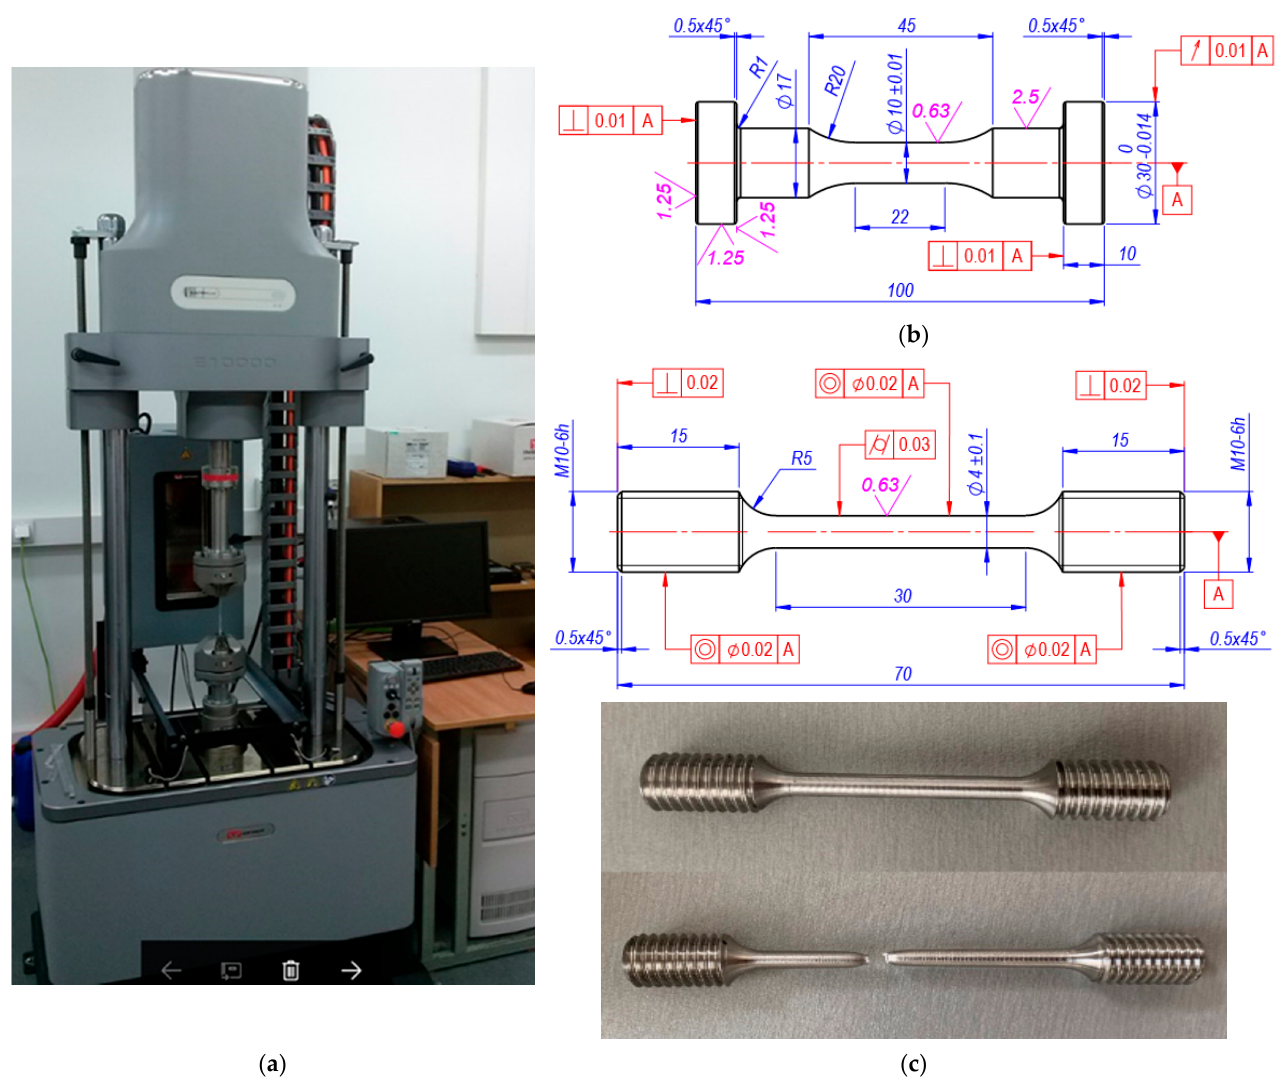
Figure 1. Equipment for tensile testing experiment ( a ), shape and dimension of the specimens for: ( b ) low—cycle fatigue tension-compression experiments, ( c ) monotonous tensile experiments (Units in mm).